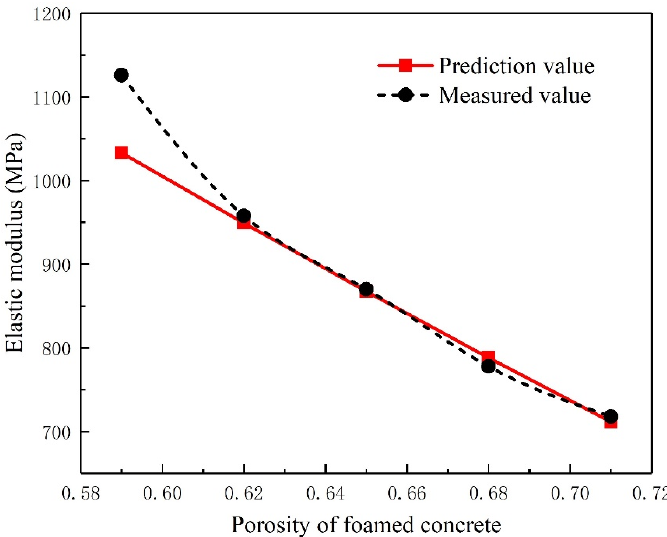
Figure 14. Variation in elastic modulus of foamed concrete with porosity.